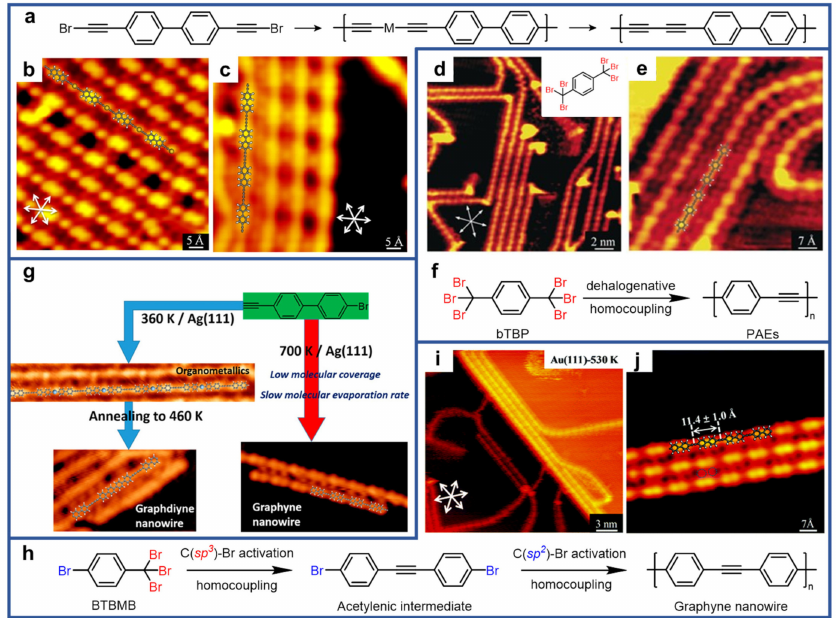
Figure 3. ( a ) Schematic illustration of dehalogenative homocouplings of 1,1 (cid:48) -biphenyl, 4,4 (cid:48) -bis(2- bromoethynyl) (BPBBE). ( b ) Close-up STM image showing the formation of the C–Au–C organometal- lic chains after deposition of BPBBE molecules on Au(111) at RT and slight anneal to 320 K. ( c ) STM image of C–C coupled molecular chains with acetylenic scaffoldings after the sample is annealed to ~425 K, with the scaled model of a molecular chain overlaid on the corresponding STM topography. Reprinted with permission from Ref. [51]. Copyright 2016, American Chemical Society. ( d ) Large- scale and ( e ) close-up STM images showing the formation of molecular chains (graphyne wires)